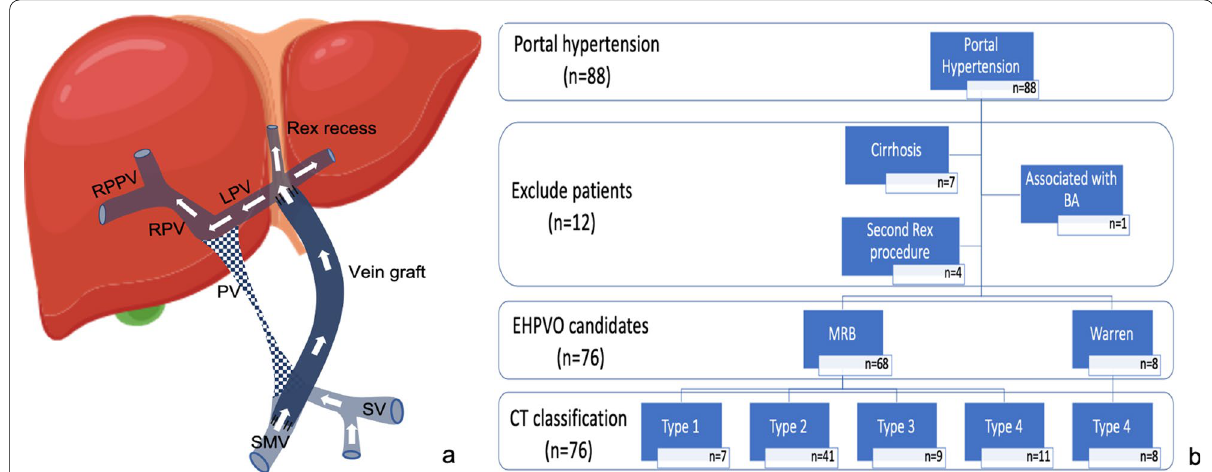
Fig. 1 a Diagram of the meso-Rex bypass procedure. b Children with portal hypertension (October 2013 to December 2019). Abbreviations: SMV, superior mesenteric vein; SV, splenic vein; PV, portal vein; LPV, left portal vein; RPV, right portal vein; RPPV, right posterior portal vein; BA, biliary atresia; EHPVO, extrahepatic portal vein obstruction; CT, computed tomography; and MRB, meso-Rex